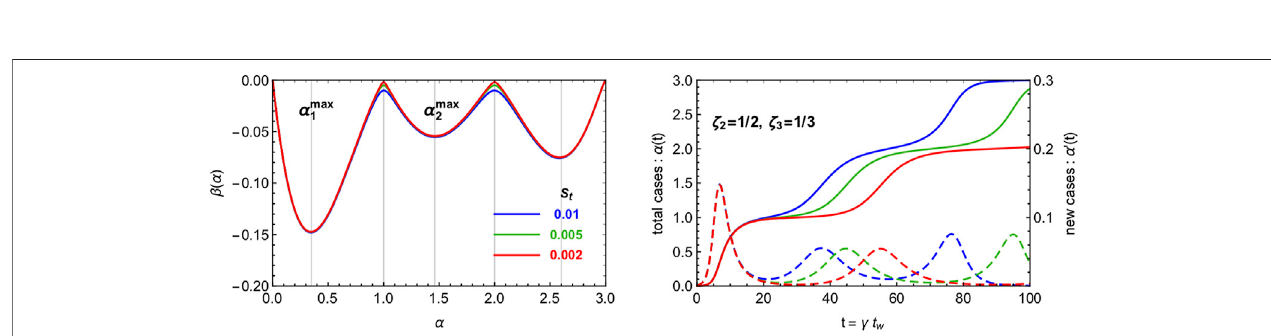
FIGURE4| Illustrationofthemulti-waveCeRGmodel,withthreewaves.Weshowthebetafunctions (right) andthesolutions (left) forthreevaluesof S t ,chosento be the same for the two strolling periods (for p 1 (cid:2) 0 . 55, p 2 (cid:2) 0 . 6, p 3 (cid:2) 0 . 65, ζ 2 (cid:2) 1 / 2, and ζ 3 (cid:2) 1 / 3).